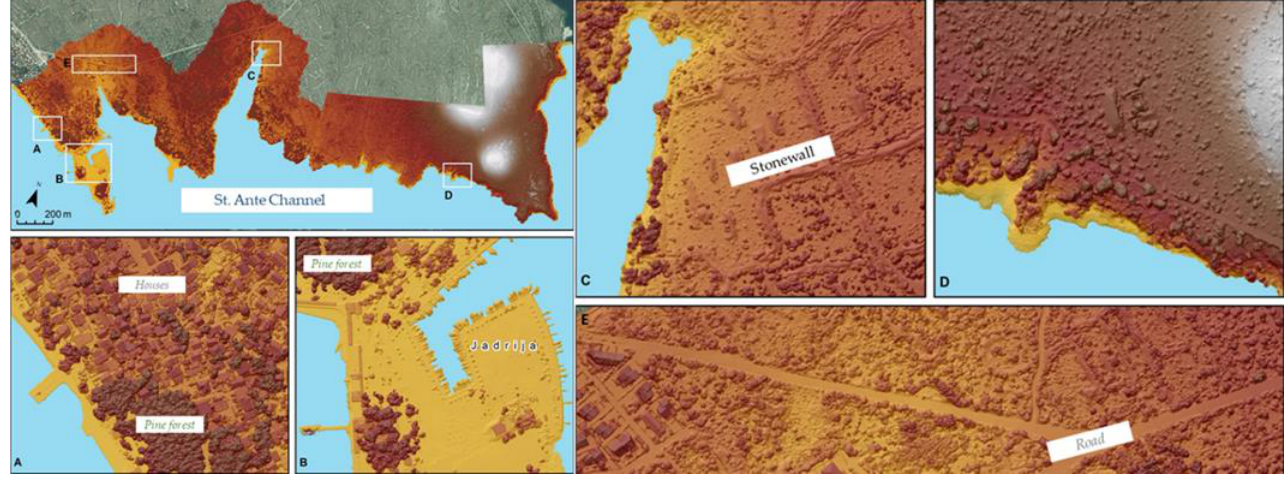
Figure 13. A section of the generated DSM of the St. Anthony Channel.